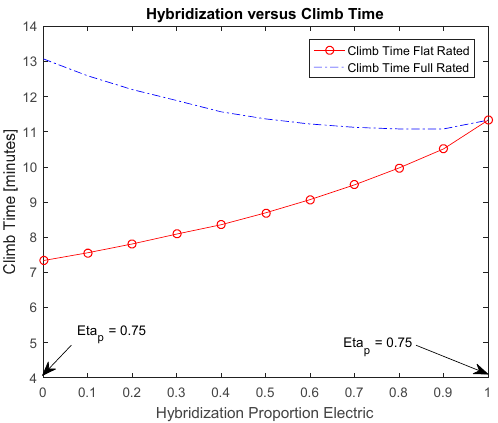
Figure 12. Time to climb vs. hybrid proportion given constant propeller efficiency.